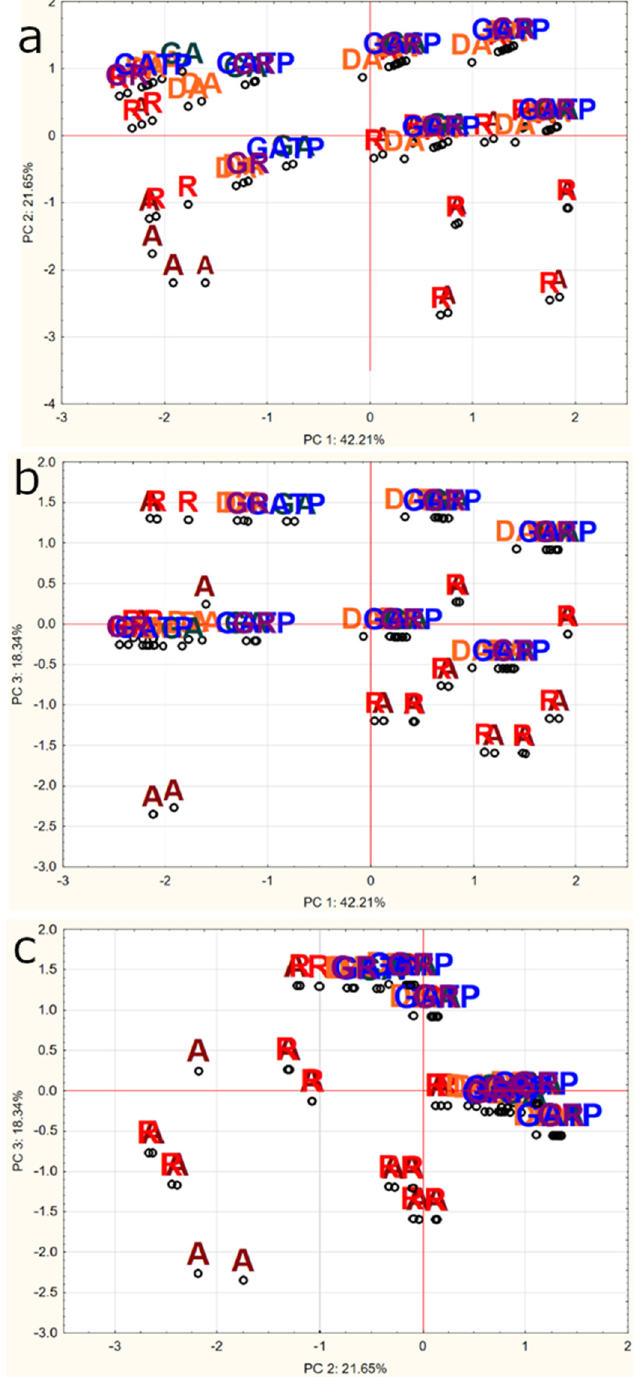
Figure 8. Plot of the principal component for the cases: ( a ) Principal Component 1 and 2, ( b ) Principal Component 1 and 3, ( c ) Principal Components 2 and 3. A—Arabica, DA—decaffeinated Arabica, GA—green Arabica, GATP—green Arabica in transparent packaging, GR—green Robusta, R— Robusta.